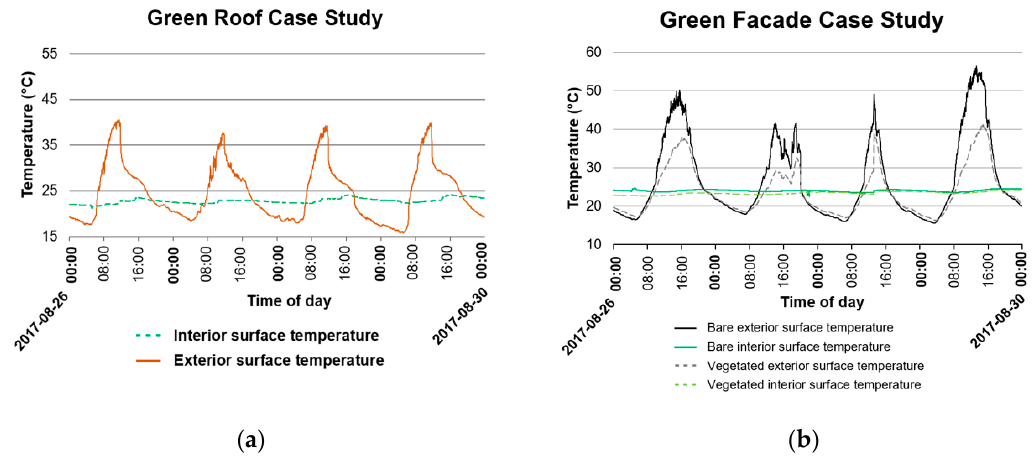
Figure 6 Temporal trends of the indoor and bare wall temperature in ( a ) Green roof case study (one simulated room); ( b ) Green façade case study (two simulated rooms)